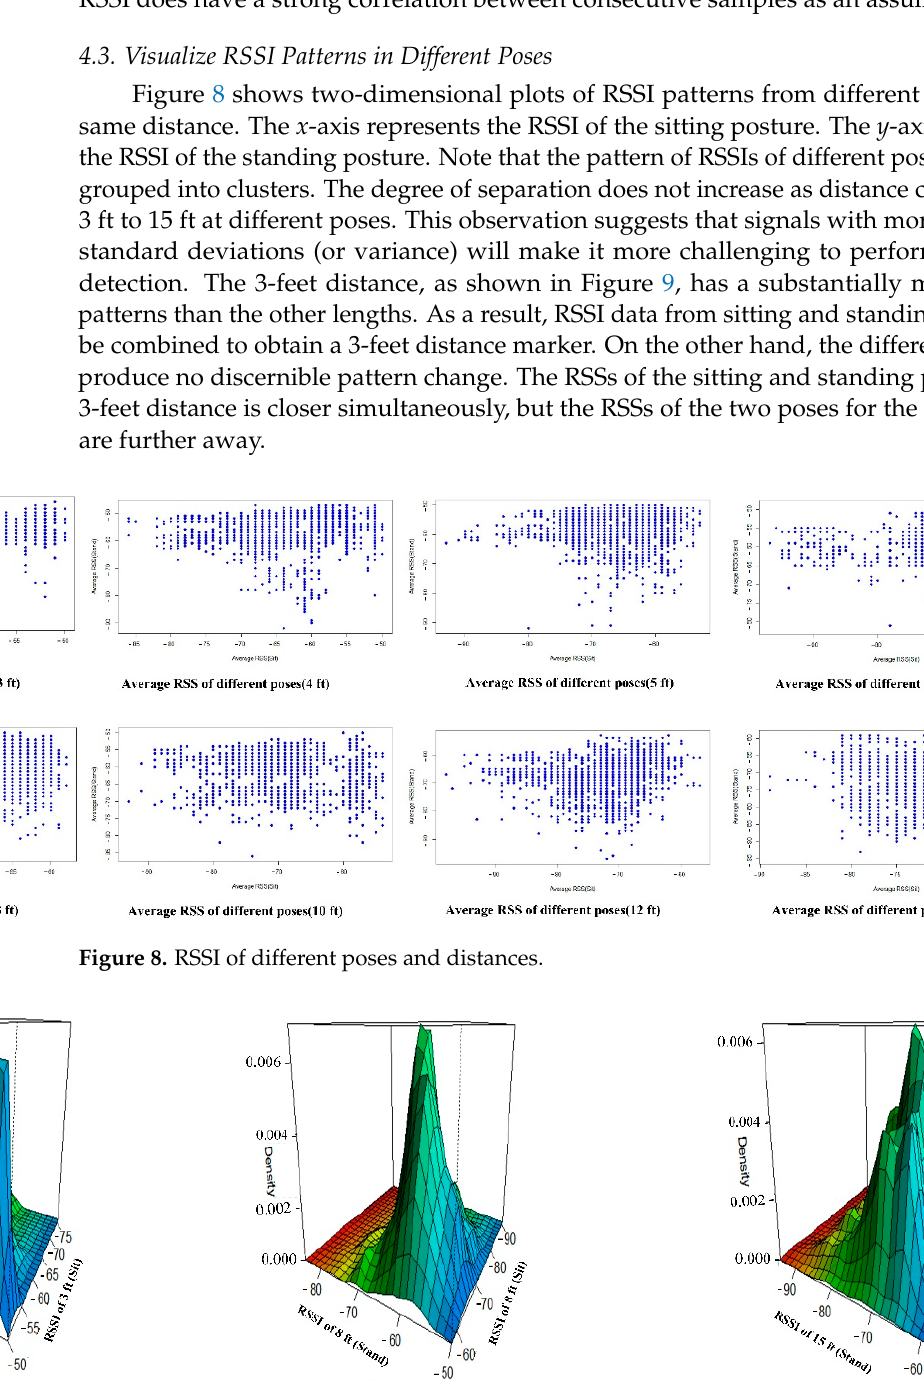
Figure 7. Correlograms of RSSI (3 ft and 15 ft, Sit and Stand).